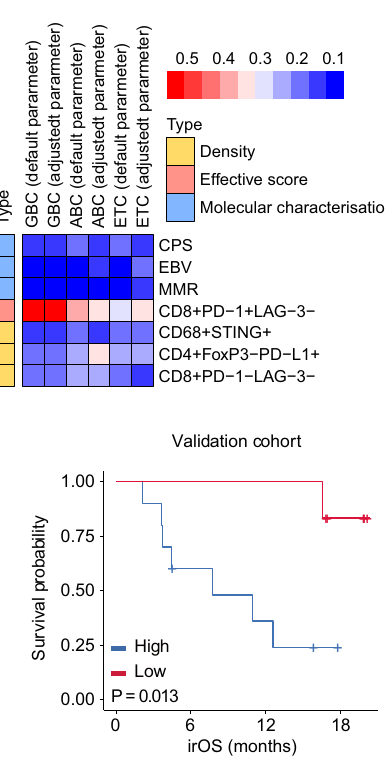
(irOS) of anti-PD-1/PD-L1-treated patients strati fi ed by the tumour-in fi ltrating immune cell (TIIC) signature in the validation cohort. Log-rank (Mantel – Cox) test was used for